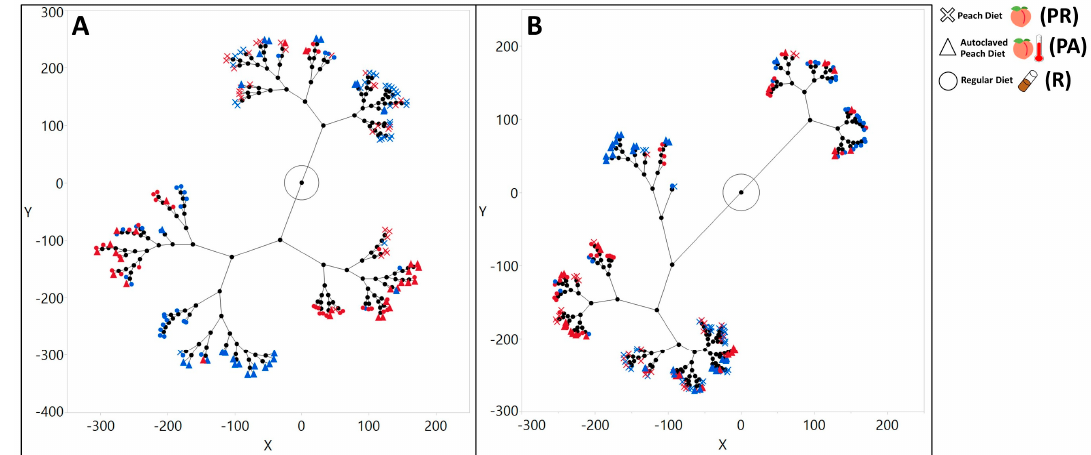
Figure 2. Larvae raised on peach and regular lab diets form distinct bacterial communities. Constellation plot based on hierarchal clustering of larvae bacterial community beta diversity distances. ( A ) Bray–Curtis distances indicate that symbiotic bacteria of the larvae raised on a peach diet is different from larvae raised on a regular diet. Symbiotic bacterial communities of PA raised larvae are more similar with R raised larvae than with PR raised larvae, especially if larvae were not sterilized. ( B ) Weighted Unifrac distances indicate that based on phylogenetic beta diversity distances PR and R diets form distinct communities. Samples from sterilized larvae are marked with a blue color and samples from non-sterilized larvae are marked with the red color. Samples raised on regular lab diet are marked with circled, on a peach diet with crosses and on peach autoclaved diet with triangles.